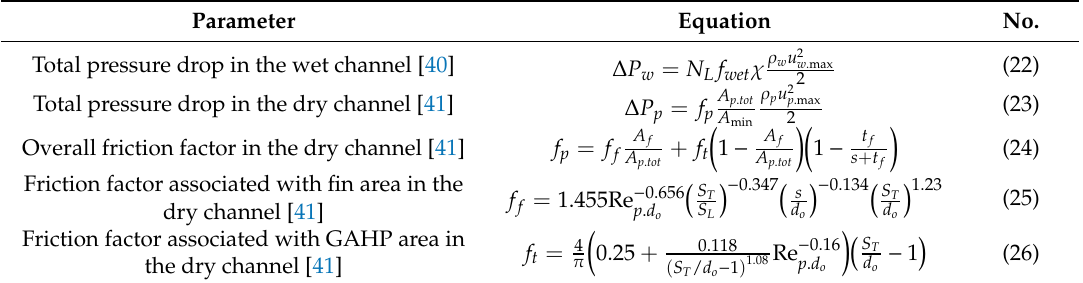
Table 4. Details of the calculated pressure drops.